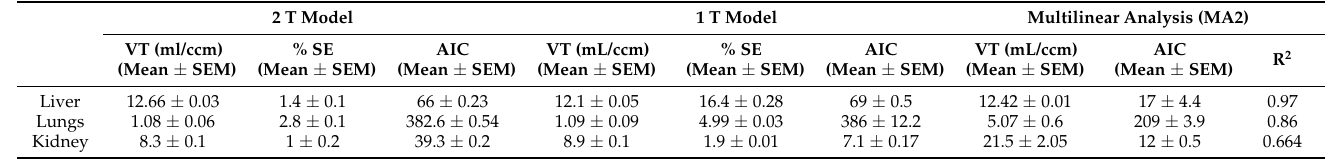
Table 3. 99 mTc Q9P35GC micelles’ kinetic-modeling